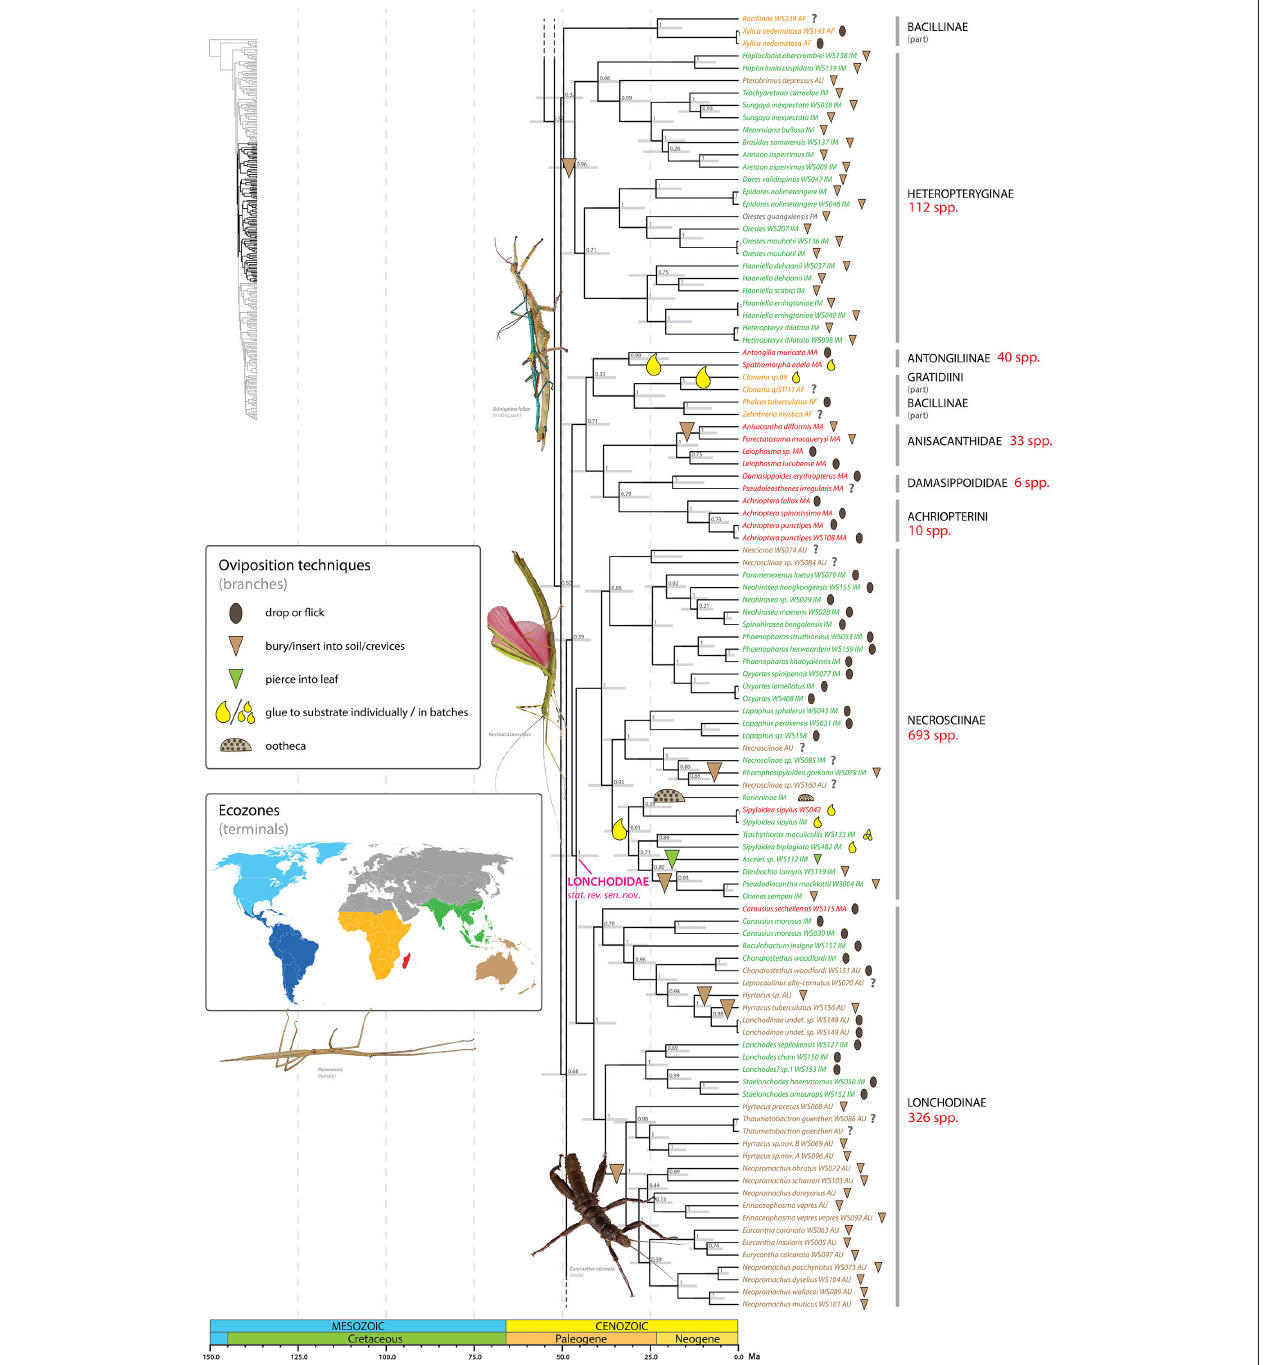
FIGURE 5 | Chronogram of Phasmatodea (part 2 of 3). The full time tree is shown to the left with the emboldened region enlarged and colored for discussion. See Figure 1 caption for details. Photos of stick and leaf insects by Igor Siwanowicz ( Achrioptera fallax ), Isselee ( Necroscia annulipes ), Bruno Kneubühler ( Prosentoria ) modified for use, Valentino2 ( Eurycantha calcarata ), used by permission.